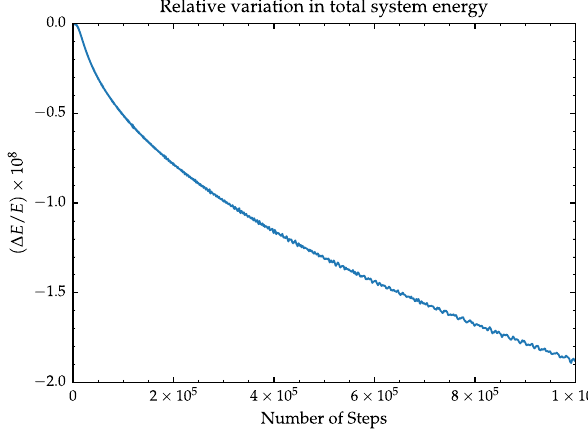
FIG. 4. Total system energy evaluated for 1000 particles and 6 modes in a cavity of length ∼ 1 . 8 km. 1 million steps of length λ 30 produced relative energy ( Δ E ) losses on the order of 10 − 8 E